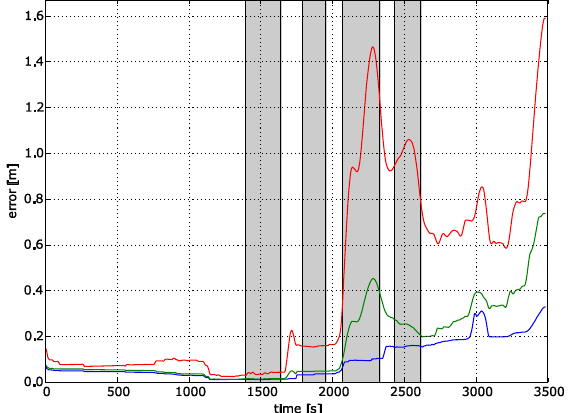
Figure 6. Estimated errors of X (blue), Y (green) and Z (red) coordinates, provided as a result of trajectory post-processing. Flight #1. Strips are marked by gray segments.